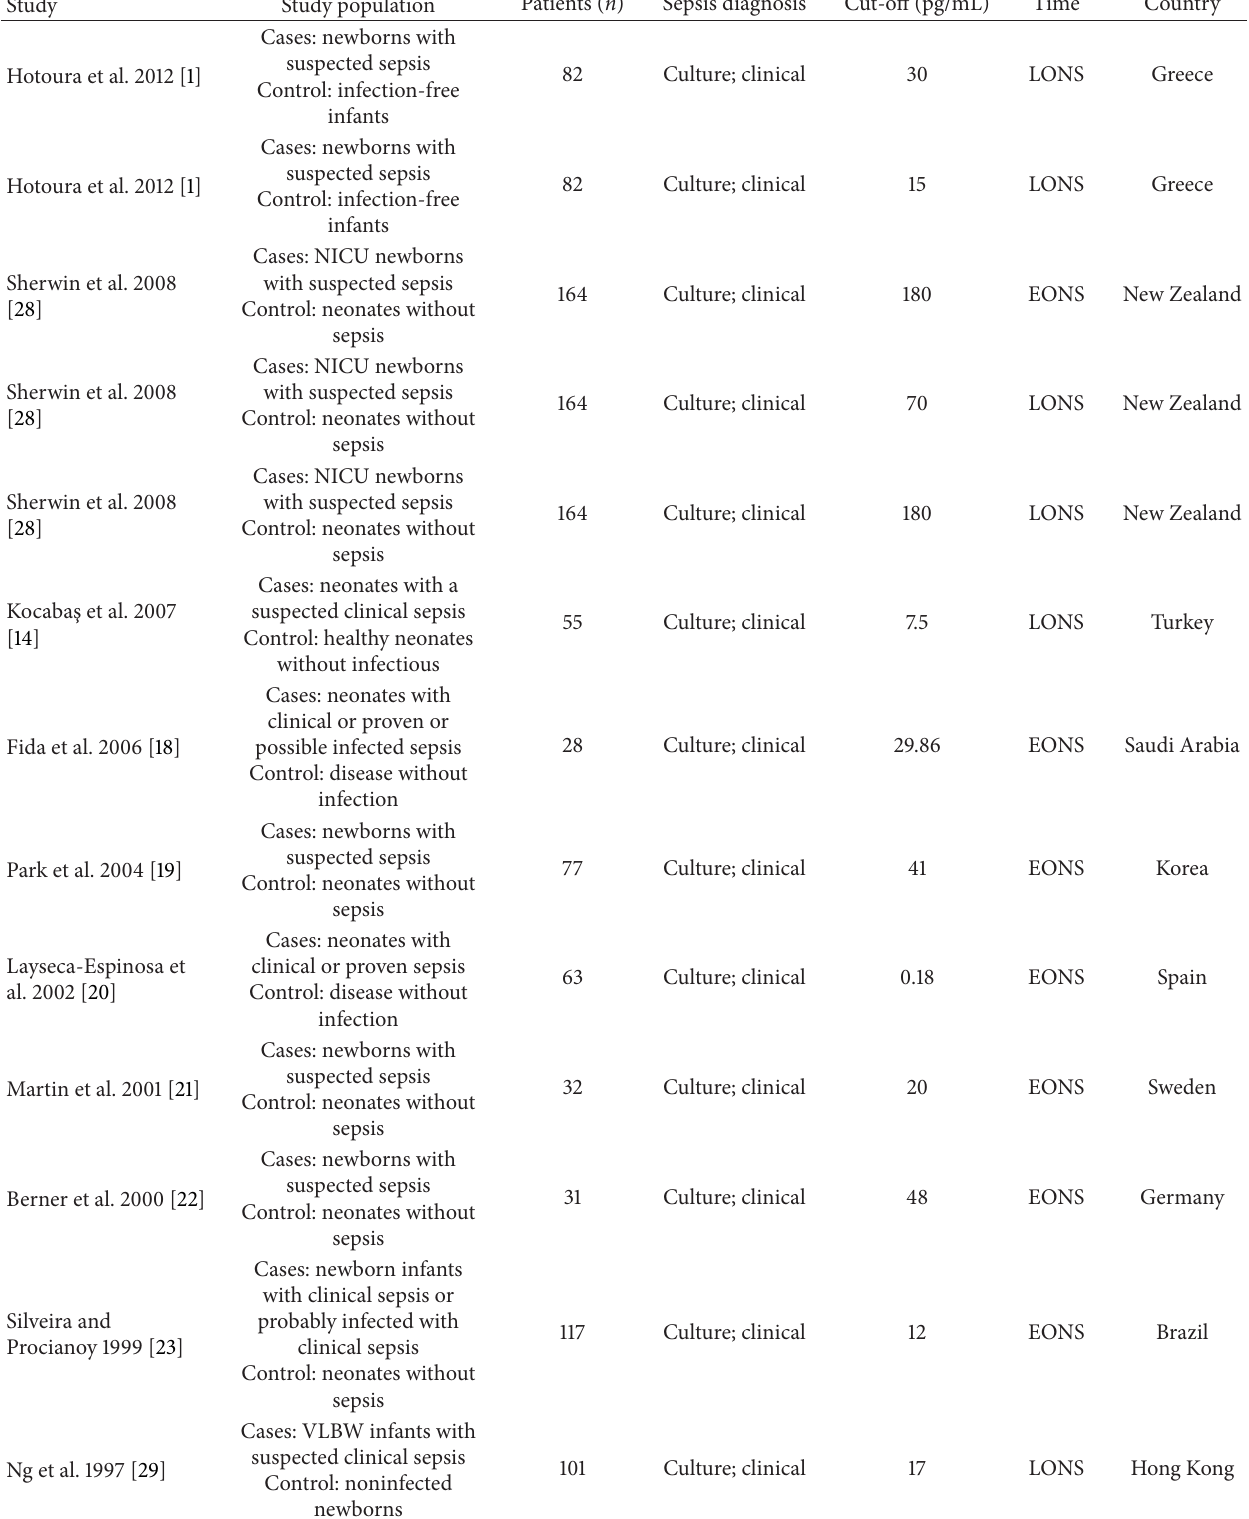
Table 1: Characteristics of studies included in the meta-analysis of the diagnosis of neonatal sepsis using a TNF- 𝛼 test. Study Study population Patients ( n ) Sepsis diagnosis Cut-off (pg/mL) Time Country Cases: newborns with suspected sepsis Culture; Hotoura et al. 2012 [1] Control: infection-free infants